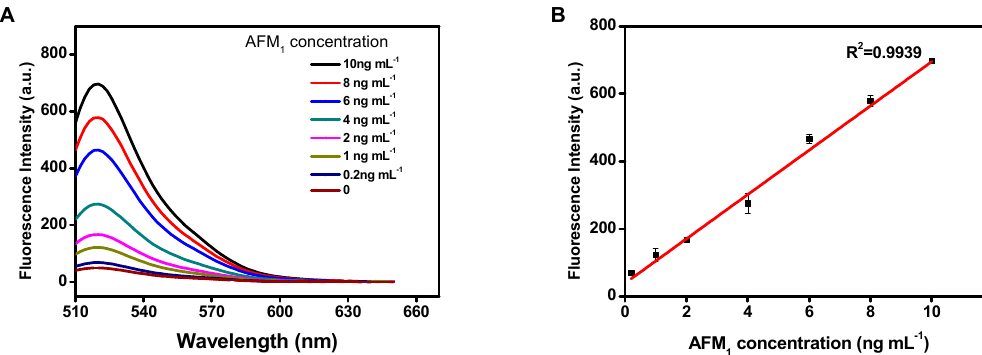
Figure 3. ( A ) Fluorescence emission spectra of the aptasensor with the addition of AFM 1 at various concentrations. ( B ) Linear relationship between fluorescence intensity and AFM 1 concentrations in the range of 0.2 to 10 ng mL − 1 . Table 1. Comparison of the sensitivity of currently available methods for the detection of AFM 1 . No.